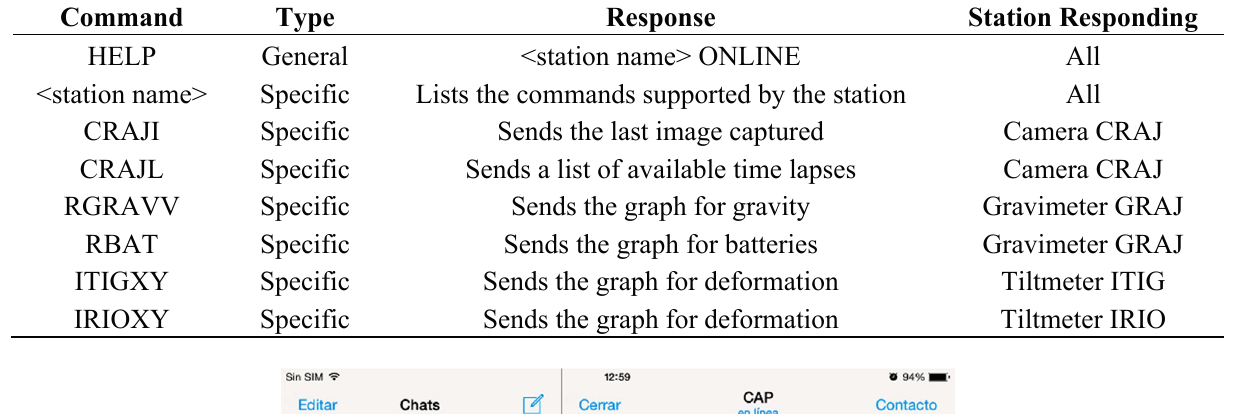
Table 13. Some of the commands supported by the stations. The general commands are answered by all stations.